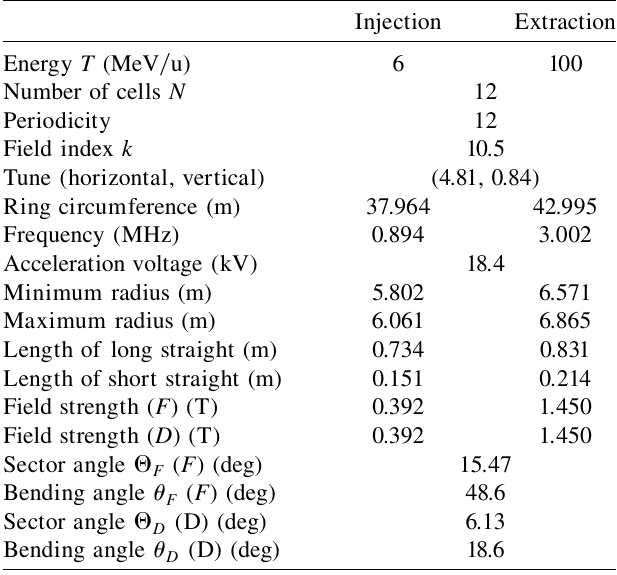
TABLE V. Basic lattice parameters of the LE-FFAG ring.